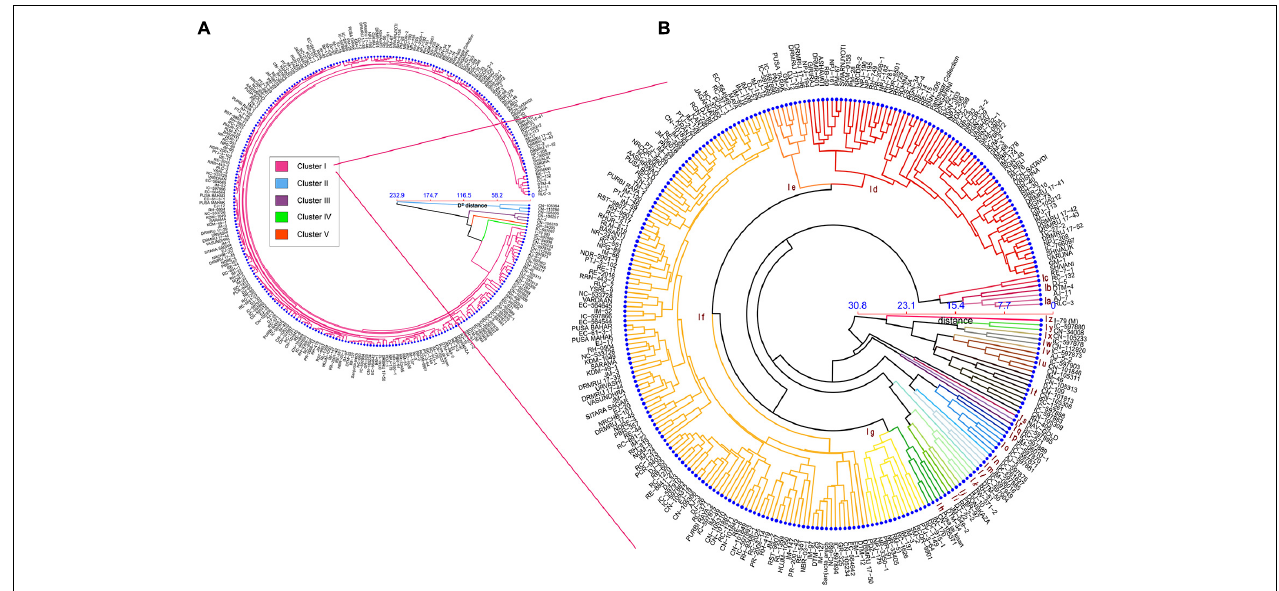
FIGURE 4 | Dendrogram showing hierarchical clustering of 289 genotypes based on Mahalanobis’s distance and the UPGMA algorithm. (A) Circular dendrogram depicted 289 genotypes distributed in five clusters. (B) Detailed dendrogram of cluster I with 26 subclusters (coded as Ia–Iz).